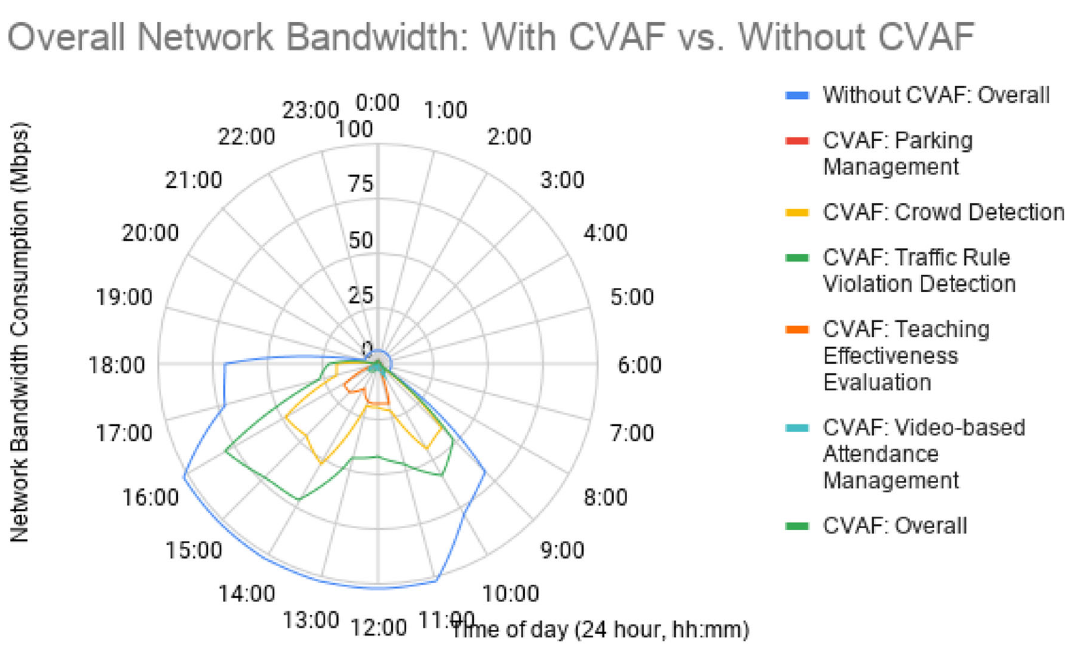
Fig. 7 Network bandwidth consumption for different video analytics applications with and without CVAF Table 5 Time taken per frame for different operations at Layer 1 and Layer 2 edge